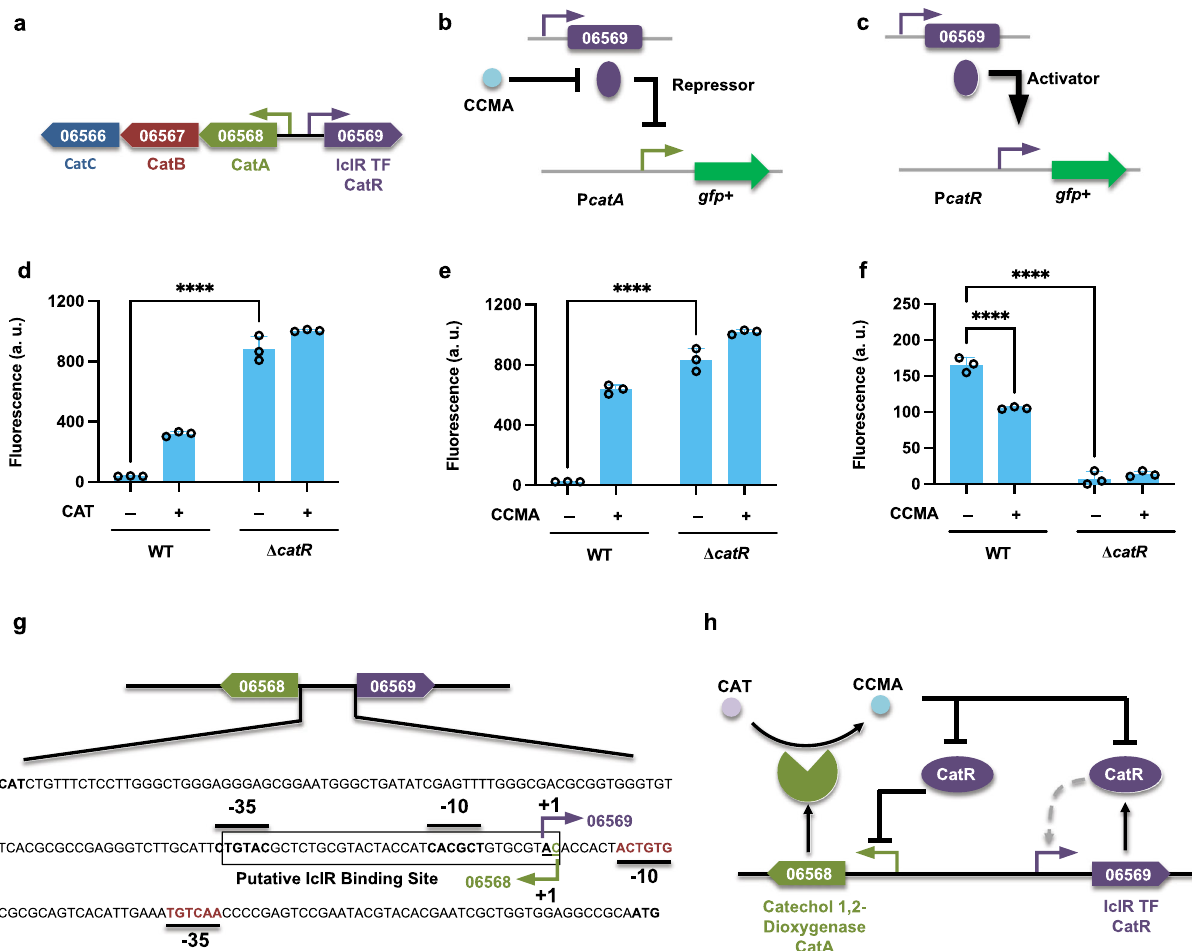
Fig. 5 Functional analysis of the transcription factor catR (LPD06569). a A catechol (CAT) degradation operon with an annotated transcriptional factor (TF). Promoters are represented as small arrows. Genes are shown with LPD gene numbers from the NCBI database (Refseq, CP003949.1). For the full annotations of the pathway genes, see Supplementary Table 1. b , c The proposed models for the role of catR . d , e To analyze the function of catR